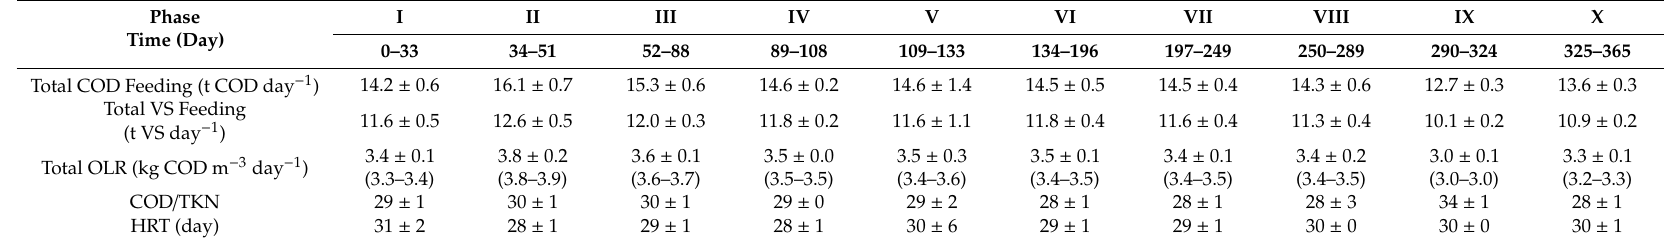
Values in parentheses indicate the limits of 95% confidence interval